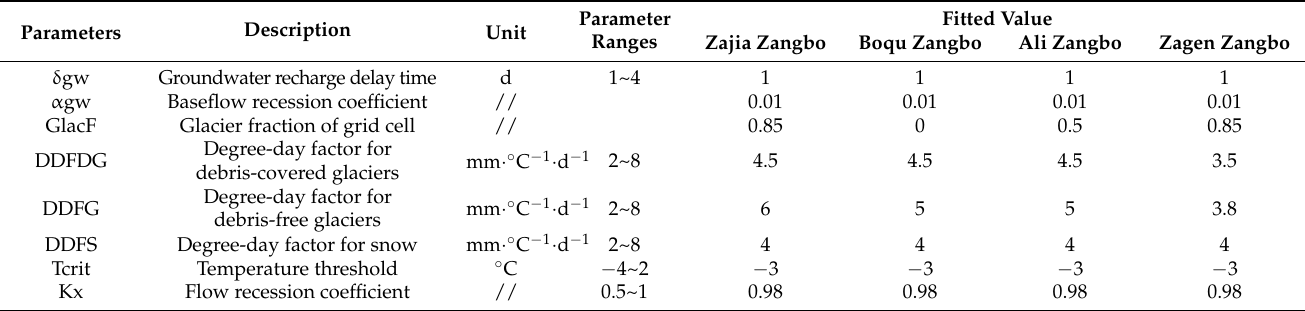
Table 2. SPHY model parameters for calibration in Siling Co.